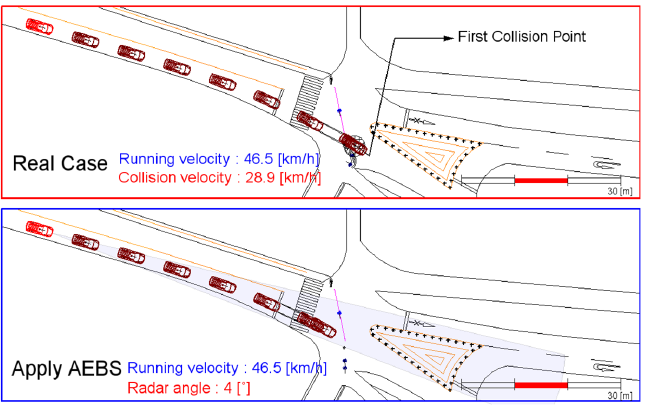
Figure 13. Real Case 1 application of the AEBS.